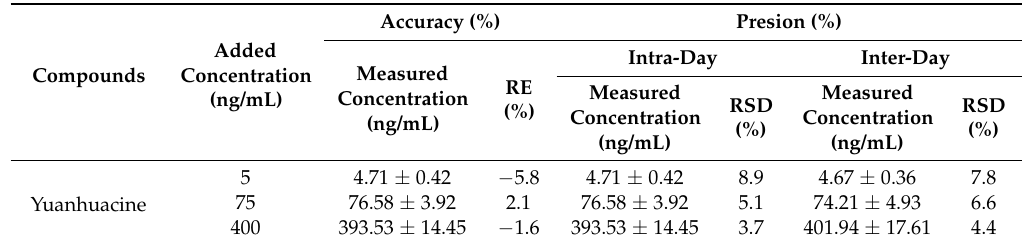
Table 1. Accuracy and precision of yuanhuacine determination in rat plasma ( n = 6).